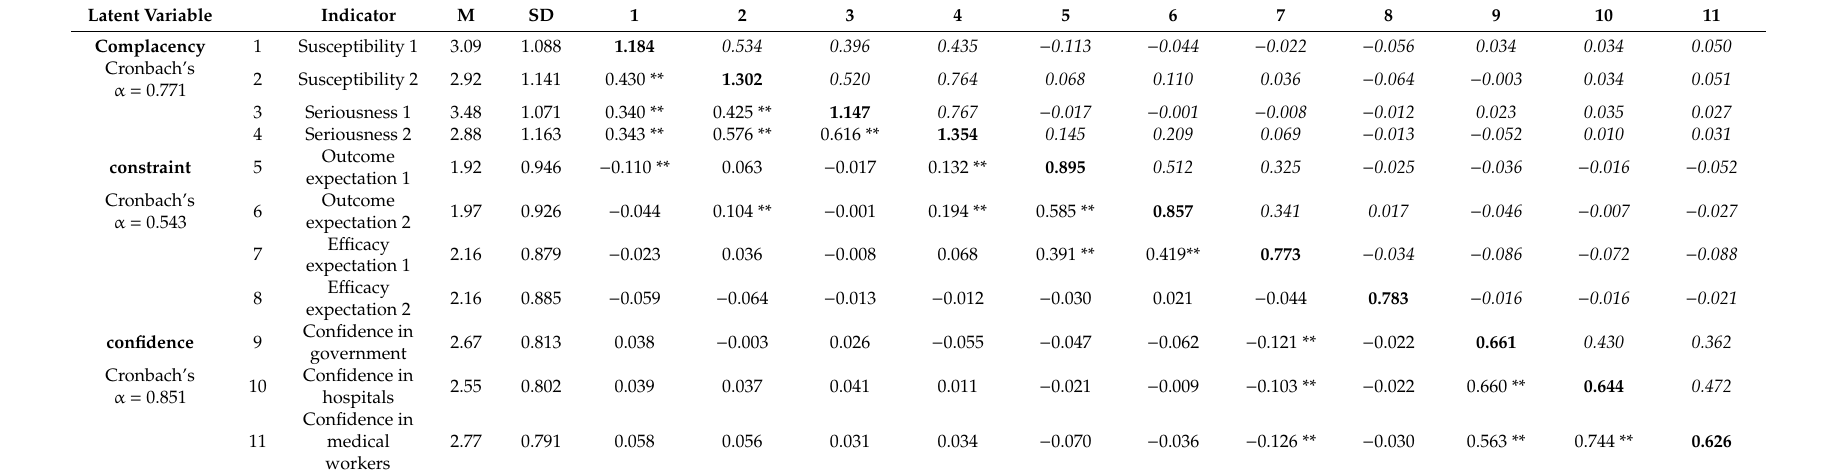
Table 2. variance, covariance, and correlations of indicators, Cronbach’s α for constructed latent variable (Israel).